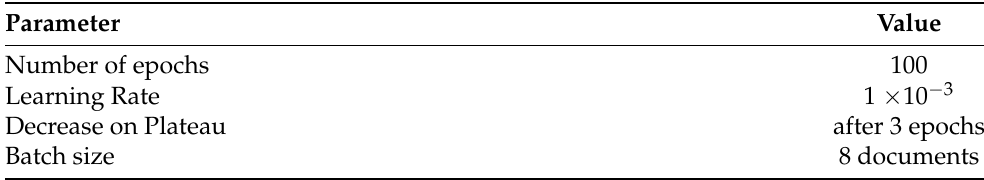
Table 4. HAN training hyper-parameters.